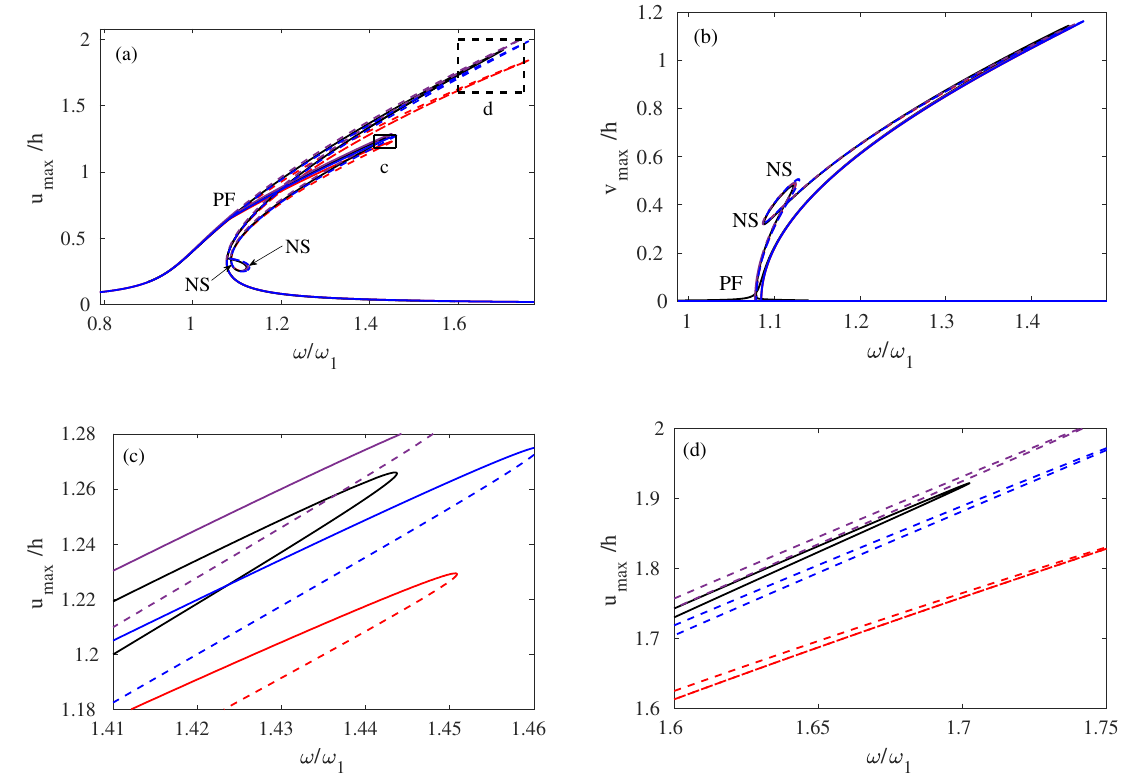
Figure 11. Frequency-response functions for the beam with 1:1 resonance with a detuning of 4.92%. ( a ) The u direction (driven mode), ( b ) the v direction (companion mode). ( c , d ) Close-up views. Full-order reference solution (black) compared to ROMs obtained with the ICE method (purple), the DNF method (red), and the QM–SMD method